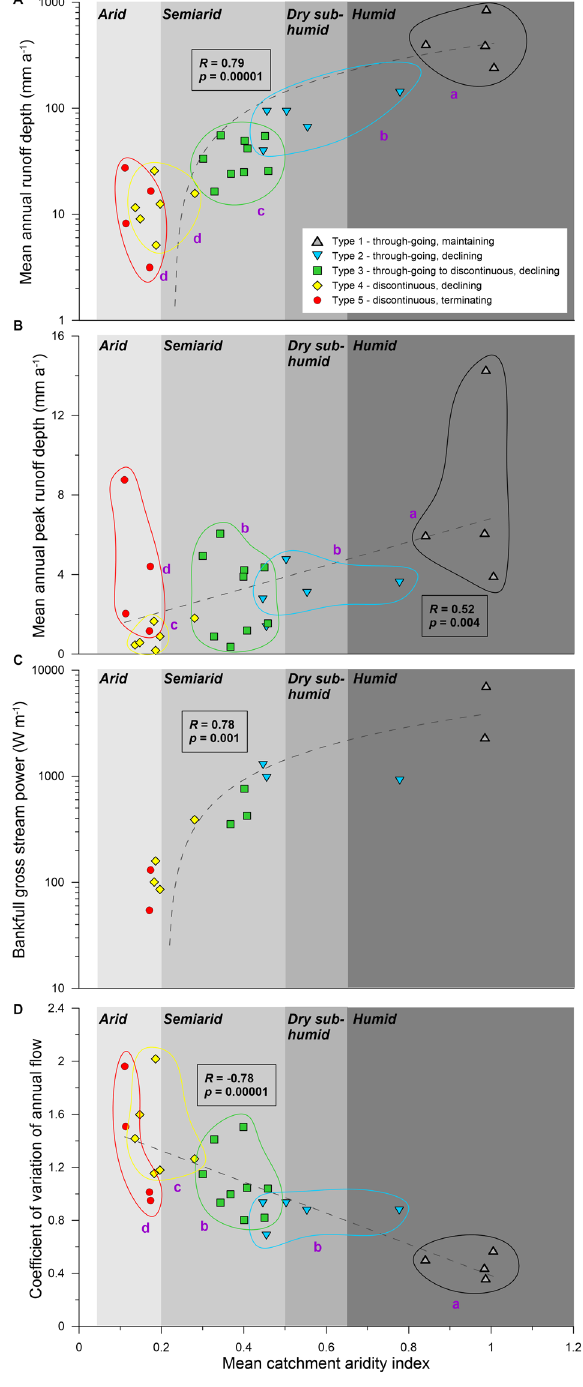
Figure 5. Mean catchment Aridity Index (AI) plotted against various hydrologic parameters from river gauge locations nearest to the end of bedrock confinement in each catchment (see Fig. 2 for gauge locations). Pearson’s correlation coefficient ( R ) indicates the strength of the linear association between the variables (note that the log-scale for A and C makes the regressions appear curved). The p-value ( p ) indicates the statistical significance of the linear correlation between the variables. Lowercase purple letters indicate the results of a pairwise ANOSIM; groups sharing the same letter are not significantly different. ( A ) mean annual runoff depth (mm a − 1 ); ( B ) mean annual peak runoff depth (mm a − 1 ); ( C ) bankfull gross stream power (estimated using bankfull discharge estimates from gauged cross sections and ratings tables). In this case, there are insufficient gauge data to confidently estimate bankfull stream power for all rivers, meaning statistical analysis across river types cannot be undertaken; ( D ) Coefficient of variation of annual flow (CV af